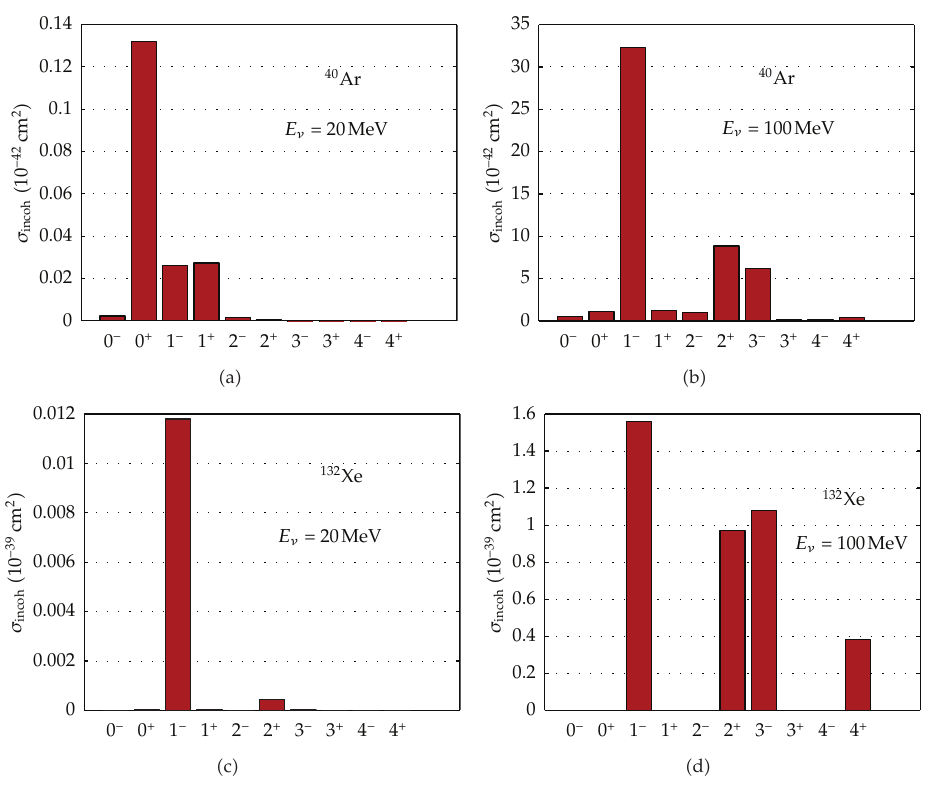
Figure 5: (cid:3) Color on line (cid:4) . Partial multipole distributions to the incoherent cross sections for 40 Ar and 132 Xe, at the incoming neutrino energies E ν (cid:8) 20 and